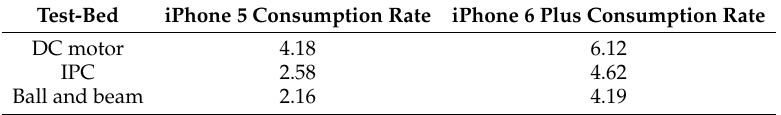
Table 5. Average battery consumption rate (min/%) of each mounted smartphone and